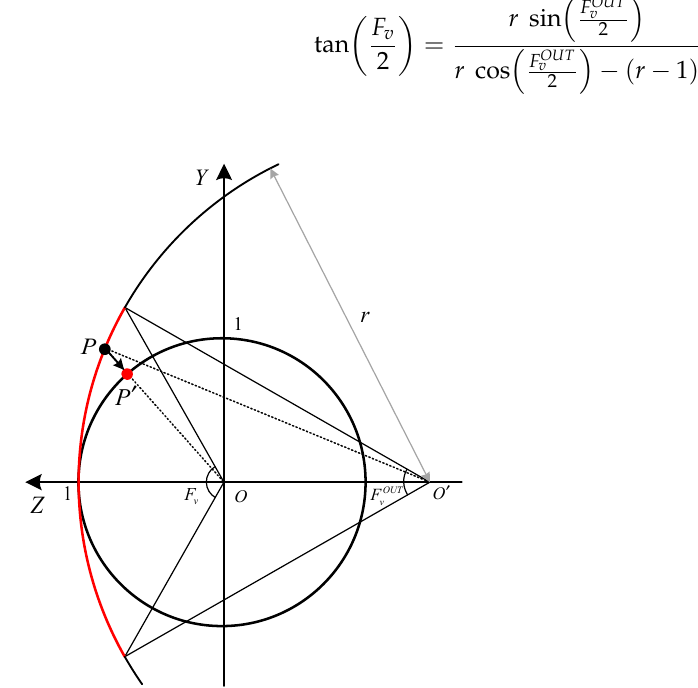
Figure 10. Cross-section of the proposed UV surface and the unit sphere.